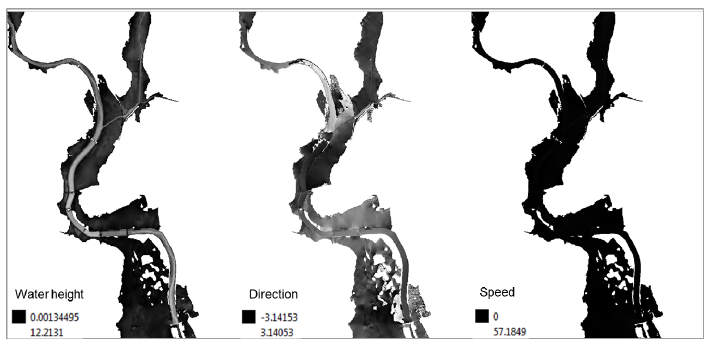
Figure 1. Visualization of raw simulated data with a grey colormap: water heights, flow directions and velocities (Al`es in the Gardon watershed), with